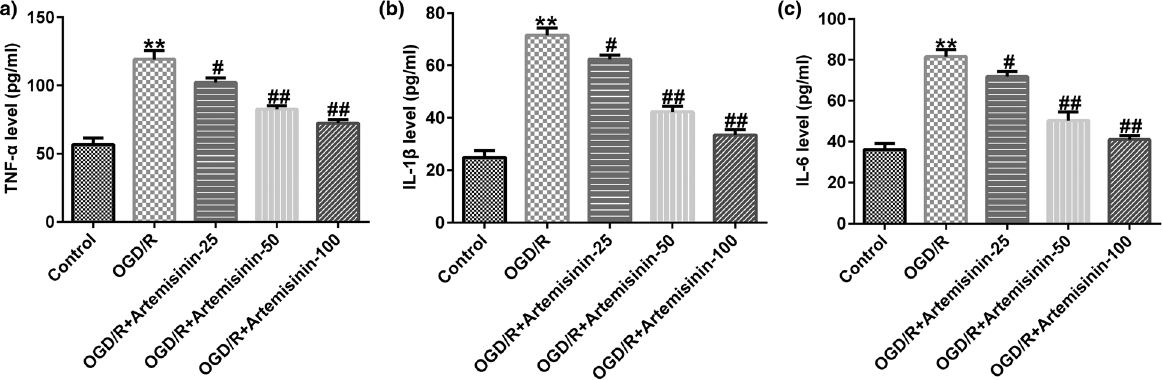
Figure 3: E ff ects of ART on cell in fl ammation in hypoxia - glucose deprivation and reoxygenation ( OGD/R )- induced SH - SY5Y cells. SH - SY5Y cells were pre - treated with the indicated concentrations of ART ( 0, 25, 50, and 100 μ M ) for 2 h and then exposed to OGD/R. ( a – c ) ELISA was used to determine the secretion of TNF - α , IL - 1 β , and IL - 6 in the supernatant of SH - SY5Y cells. ** p < 0.01 vs Control; #,## p < 0.05, 0.01 vs OGD/R.